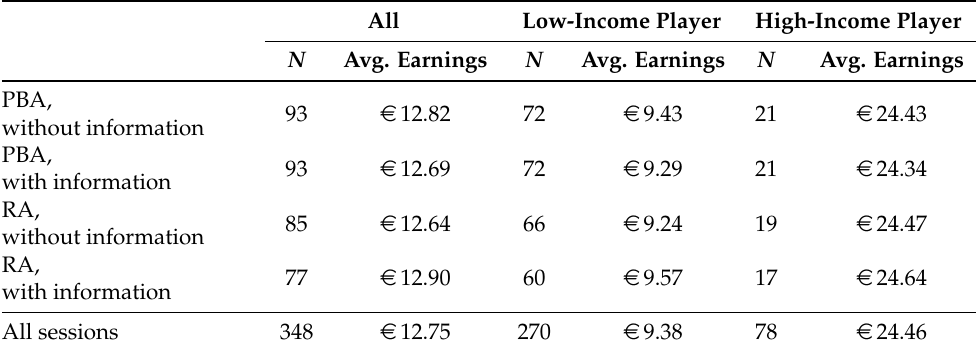
Table 2. Number of observations and average earnings by session type and player type. All Low-Income Player High-Income